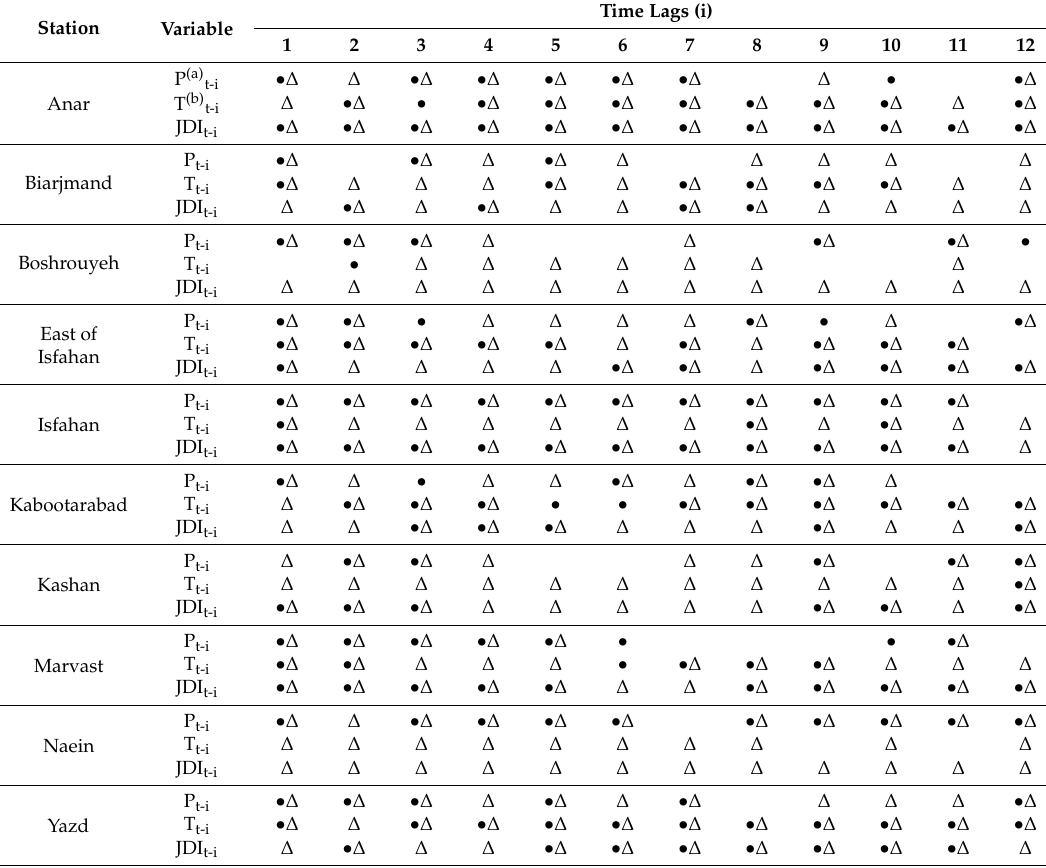
Table 3. Chosen inputs by gamma test ( • ) and entropy theory ( ∆ ) for joint deficit index (JDI). Station